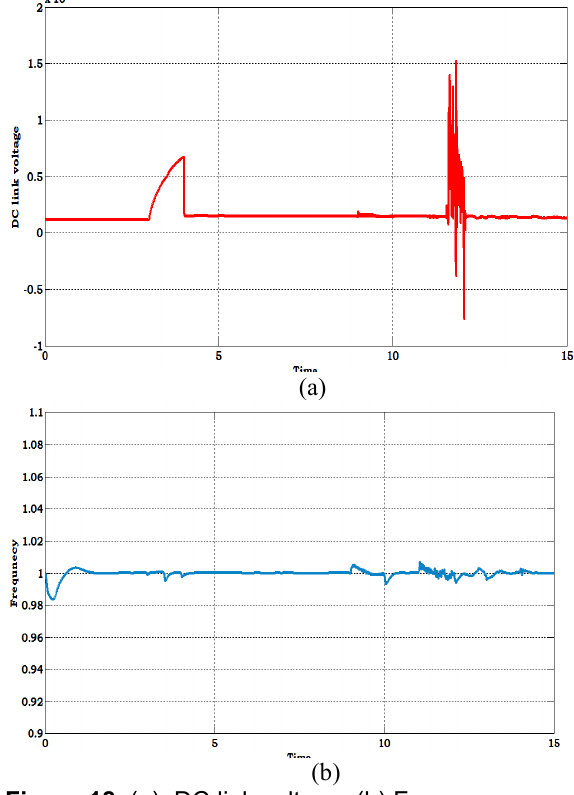
Figure 18. (a). DC link voltage, (b).Frequency Other units are suddenly connected at t=12sec, hence small disturbance observed in DC link voltage but controller brought back voltage in accurate constant value and frequency also maintained with in the limit perfectly. Test Case 4: When operating system in grid connected mode with sudden